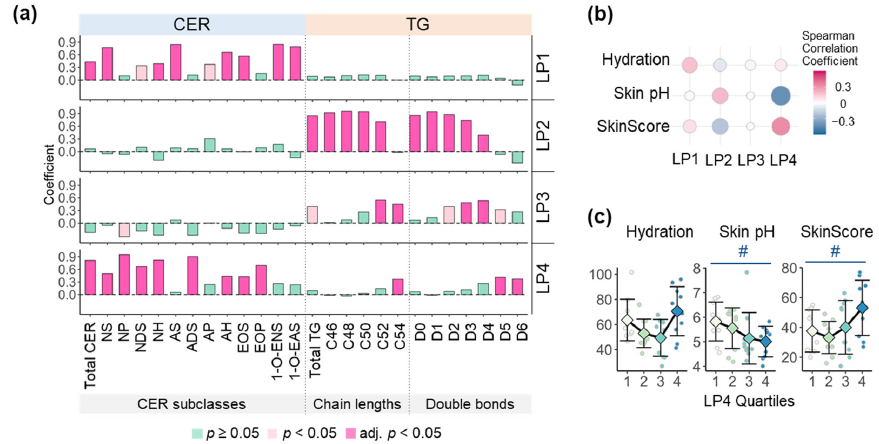
Figure 4. Characteristic of lipid patterns (LP) and association of LP with skin health parameters. LP were extracted from the combined data of skin surface ceramide (CER) and triacylglycerol (TG) using factor analysis. ( a ) Spearman correlations of LP with CER subclasses and TG categorized by total acyl chain lengths and double bonds. Adj. p was calculated using Benjamini–Hochberg (BH) method to correct multiple tests. Non-hydroxy fatty acid (FA) [N], α -hydroxy FA [A], Esterified ω -hydroxy FA [EO], 1-O-acyl FA [1-O-E], Dihydro-sphingosine [DS], Sphingosine [S], Phytosphingosine [P], and 6-Hydroxy sphingosine [H]. ( b ) Spearman correlations between LP and skin health parameters including hydration, skin pH, and the SkinScore calculated with hydration and skin pH (Higher SkinScore indicates higher hydration and lower skin pH). ( c ) Alterations in skin health parameters across LP4 quartiles (means ± standard deviations). Analysis of variance (ANOVA) with contrast was conducted to calculate p for trend, followed by multiple tests correcting with the BH method. # adjusted p for trend <